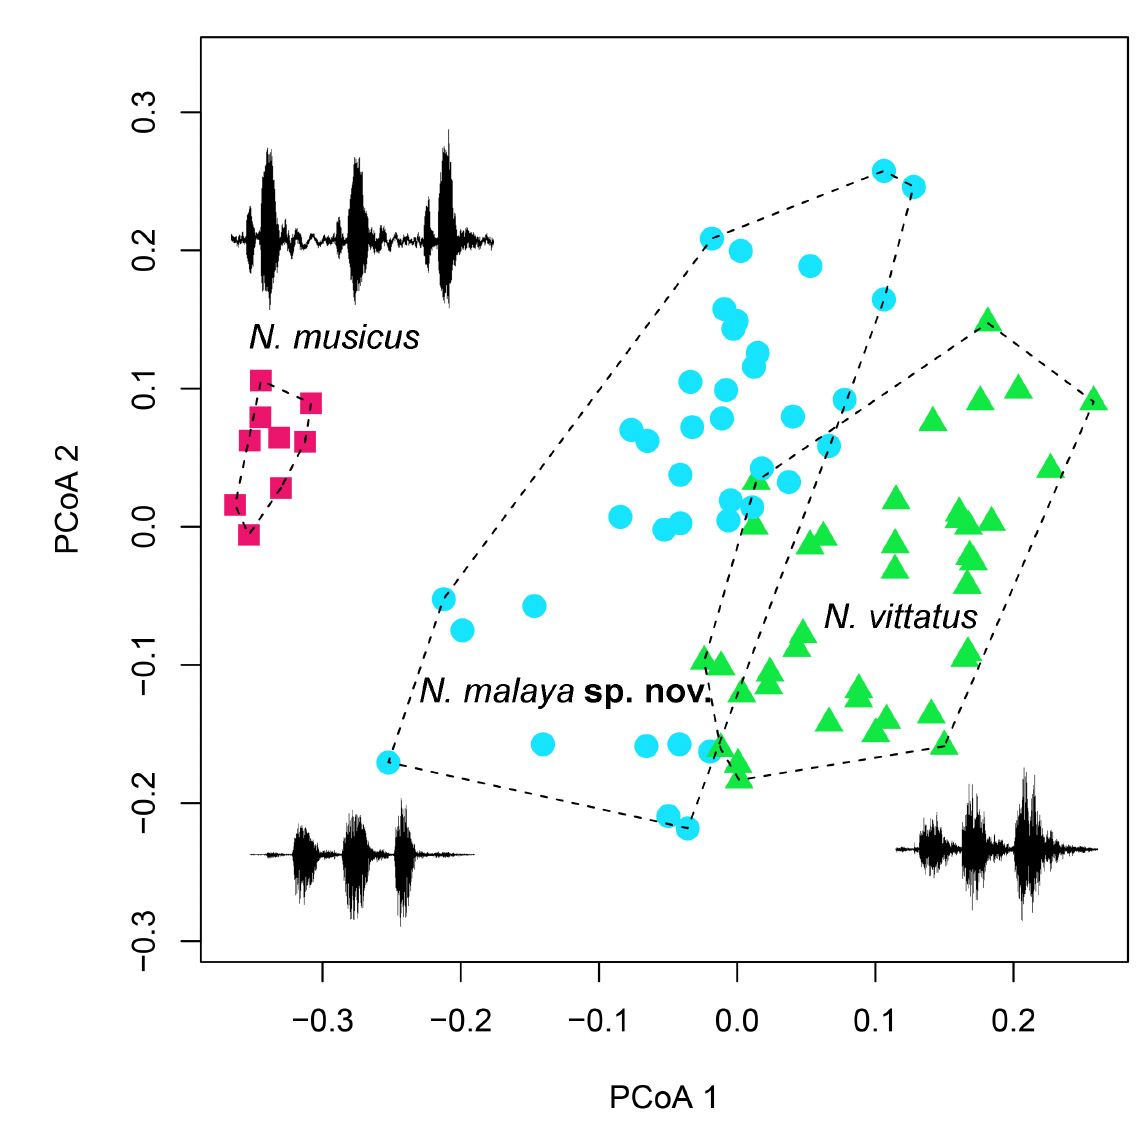
Fig. 26. Principal Coordinates Analysis (PCoA) of the acoustic properties of the calling songs of N. vittatus (Haan, 1844), N. malaya Robillard & Tan sp. nov. and N. musicus Ingrisch,